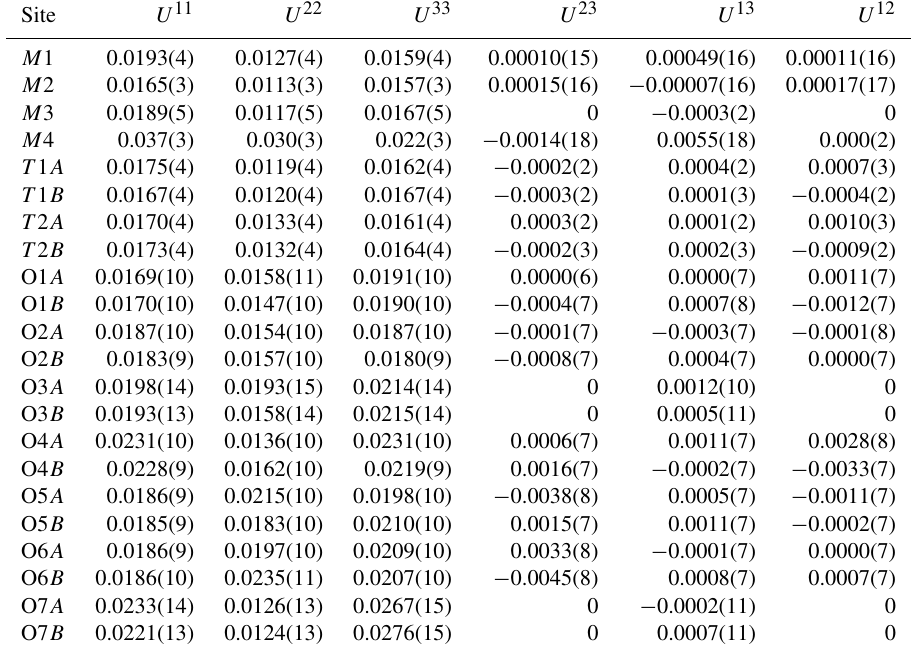
Table 5. Anisotropic displacement parameters of ferro-ferri-holmquistite.